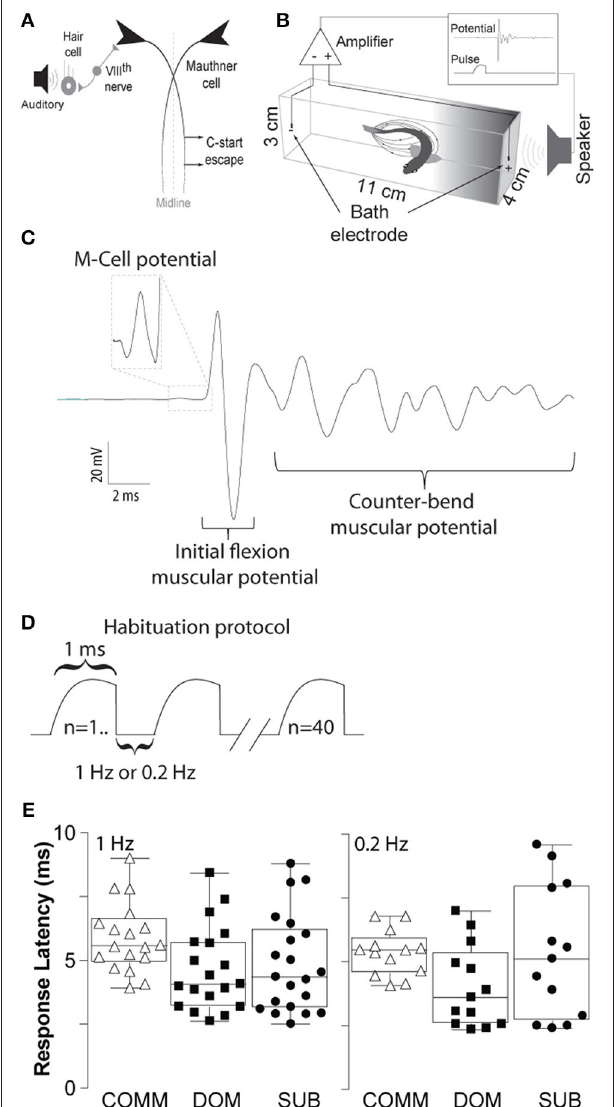
FIGURE 1 | Schematic illustrations of the M-cell escape circuit, experimental setup and recording. (A) Schematic illustration of the M-cell escape circuit. Zebrafish startle response is activated by auditory stimuli. C-start behavior is mediated by the Mauthner neural circuit. M-cell innervates contralateral spinal cord motor neurons that activate the musculature. Activation of the M-cell is necessary for C-start escape. (B) A pair of bath electrodes is placed on each end of each testing chamber. Bath electrodes detect neuromuscular field potentials generated as the M-cell escape response is activated. M-cell escape is activated by an auditory pulse. Field potentials and stimuli are time-locked and digitally recorded. (C) An illustrative example of a phasic field potential recording during activation of the C-start escape response mediated by the M-cell followed by C-start bend and counter-bends. (D) Representation of the repeated auditory stimuli at 1 and 0.2Hz. (E) Latency between the stimulus and the phasic potential for communals (COMM), dominants (DOM), and subordinates (SUB) at 1 and 0.2Hz. Mean ± SEM was